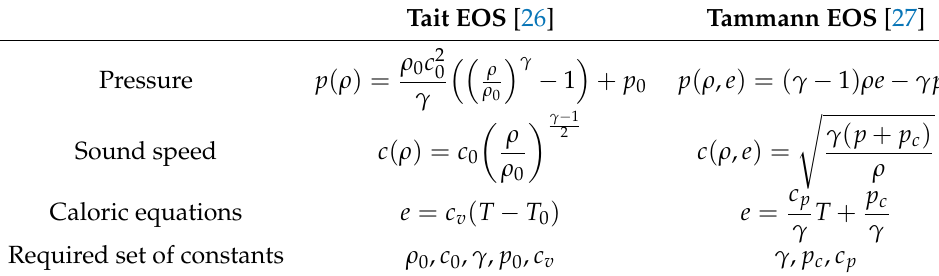
Table 1. Constitutive equations for Tait and Tammann EOS.